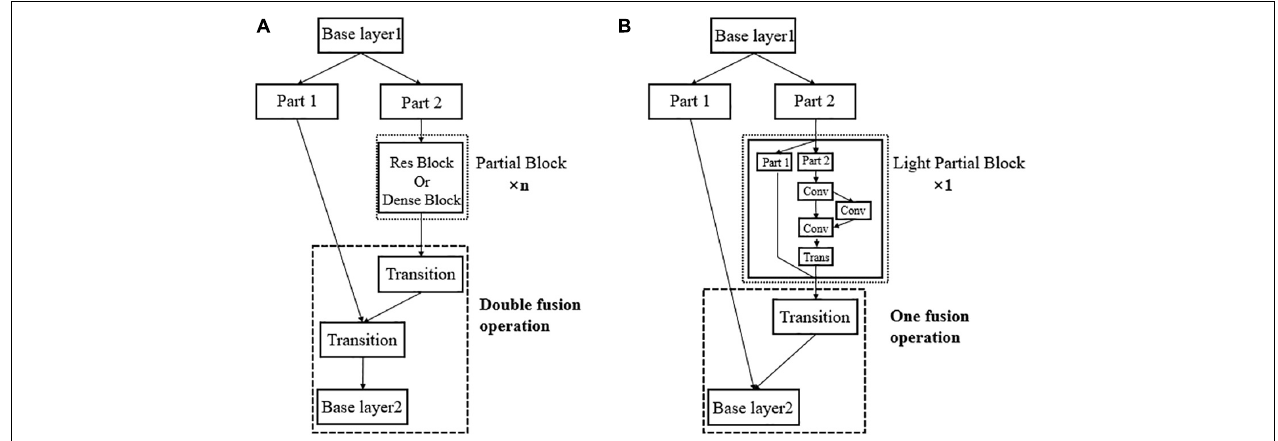
FIGURE 3 | Using the excellent structural design of CSPNet, we propose a lightweight network model, Light-CSPNet. Here, the n partial block in the original network is replaced with a lightweight, specifically designed light partial block, and the double fusion operation is replaced with one fusion operation to further improve the network operation speed. (A) Shows the network architecture of CSPNet; (B) Shows the network architecture of the proposed Light-CSPNet.